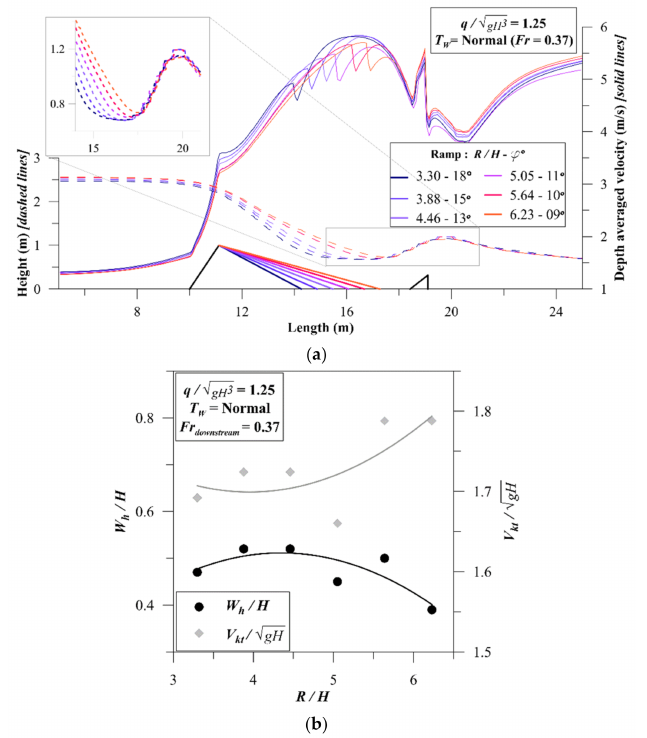
Figure 6. Effect of the ramp profile on the surf wave: ( a ) effect of the ramp steepness on wave profile and velocity distribution, ( b ) sensitivity of the surf wave to ramp slope.